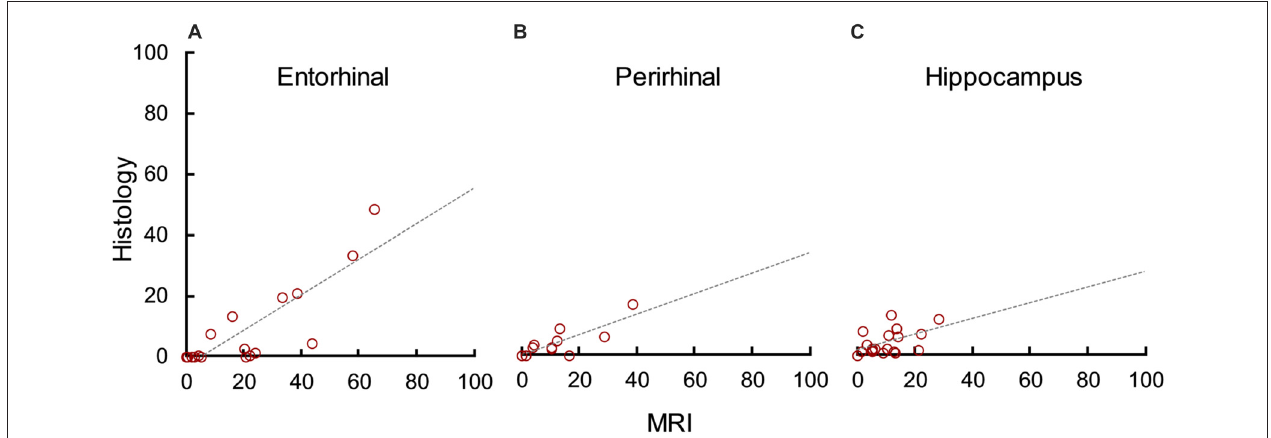
FIGURE 5 | MRI hypersignal predicted but overestimated unintended damage to surrounding structures. Percent unintended damage to the entorhinal cortex (A) , perirhinal cortex (B) and hippocampus (C) as estimated by T2 MRI and by histological examination. Each dot represents one hemisphere ( n =